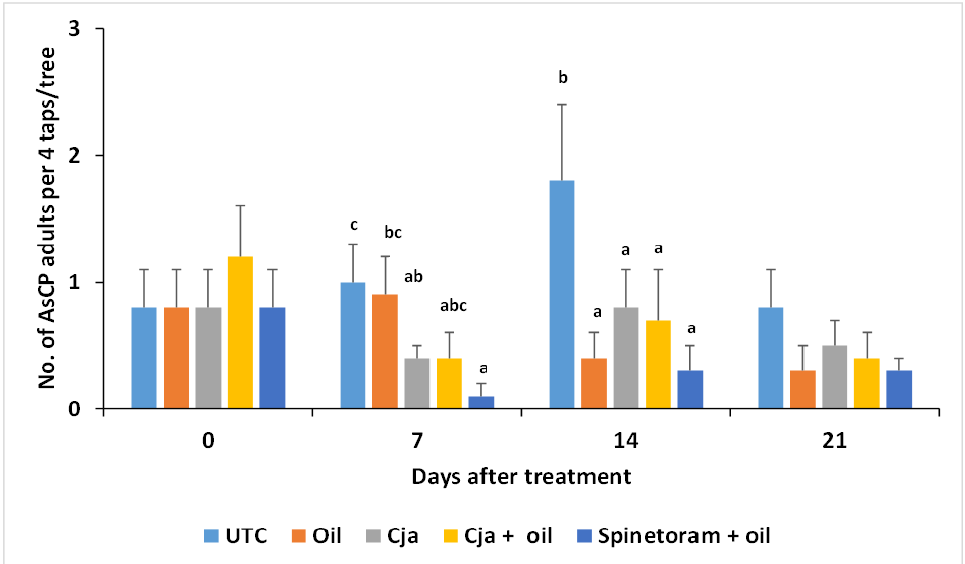
Figure 2. Mean number ± SE of Asian citrus psyllid (AsCP) adults per four stem taps per tree for each treatment on different days after treatment in Trial 1. The mean values with a different letter above the ±SE bar are significantly different (LSD test; p < 0.05). There were no